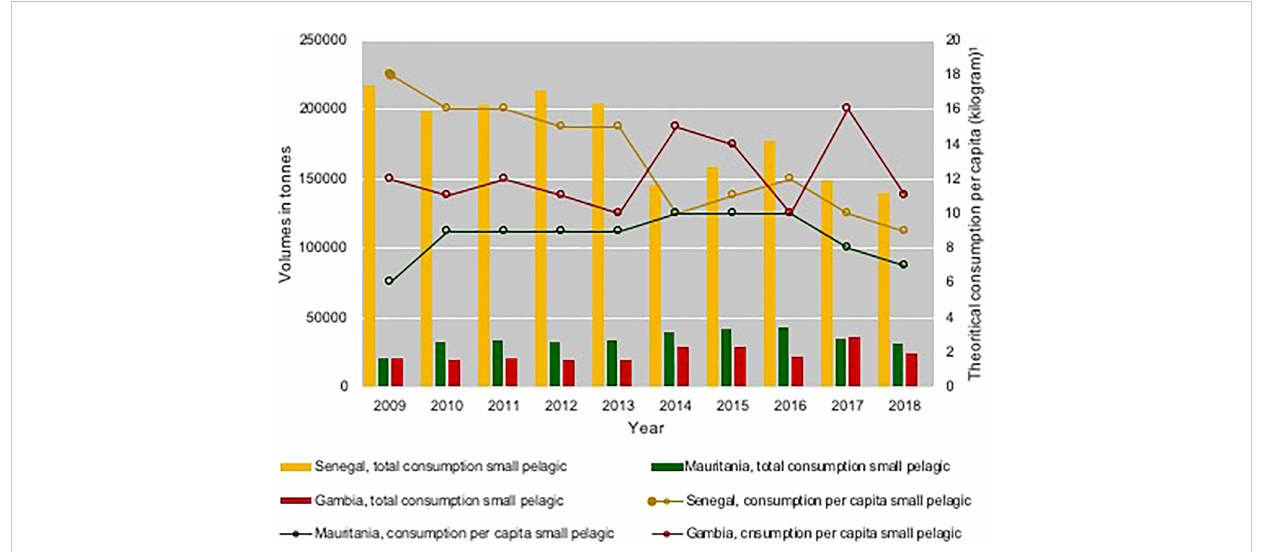
FIGURE 3 Theoretical Consumption of small pelagics in the Gambia, Mauritania and Senegal. Source: Data GBoS, CRODT, IMROP. 1 Per capita theoretical availability of small pelagics = (Small pelagic production + Small pelagic imports - Small pelagic exports)/population.